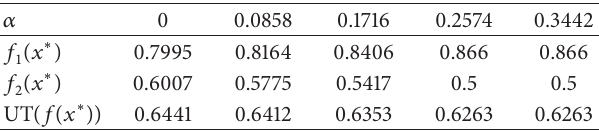
Table 10: The efficient points of the subproblems according to different values of 𝛼 for Example 3.